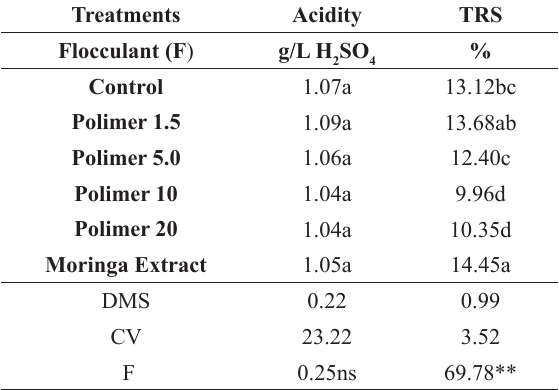
Results for TRS and Total Acidity of the must obtained from clarified juice with 5 sedimentation